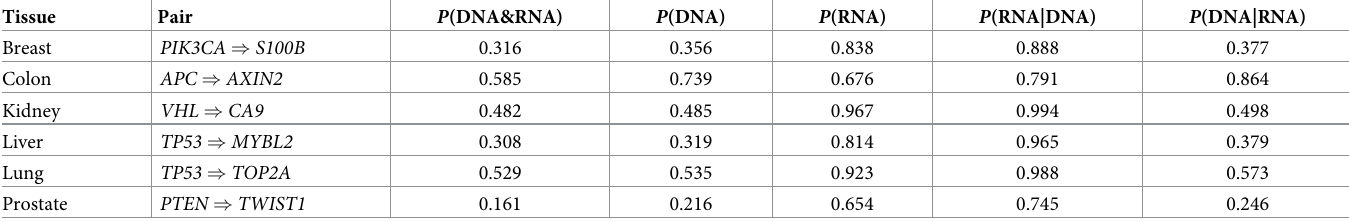
Table 1. Examples of STPs. For each of the six tissues, one example of a common STP λ = ( g ) g 0 ) is shown. P (DNA&RNA) is our sample-based estimate of the probabil- ity that λ is an aberrant pair, namely, the fraction of samples of the indicated tissue for which the source gene g is DNA-aberrant and the target gene g 0 is RNA-aberrant. Similarly, P (DNA) (respectively, P (RNA)) is the fraction of samples for which g is DNA-aberrant (resp., g 0 is RNA-aberrant), and P (RNA|DNA) is the (estimated) condi- tional probability that g 0 is RNA-aberrant given g is DNA-aberrant. Tissue Pair P (DNA&RNA) P (DNA) P (RNA) P (RNA|DNA) P (DNA|RNA) Breast